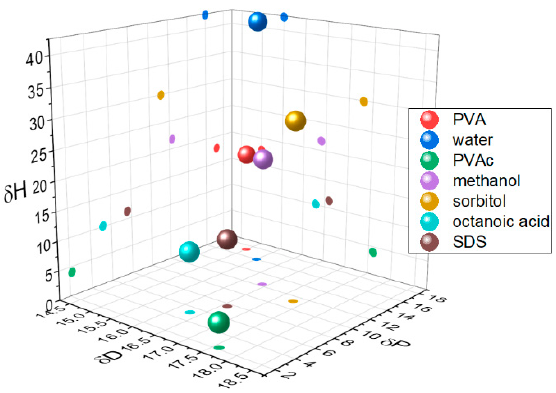
Figure 1. Hansen solubility parameters for polymers, additives, and solvents.